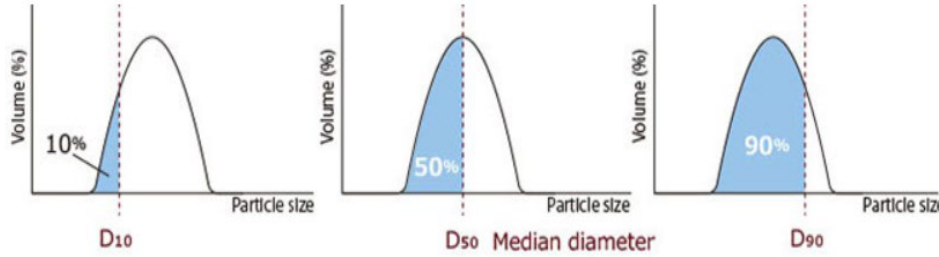
Figure 5. Definition of the D 10 , D 50 , and D 90 percentile values for the sediments. Table 2. Quantile comparison of the different methods and grain size statistics of the Baganza River.